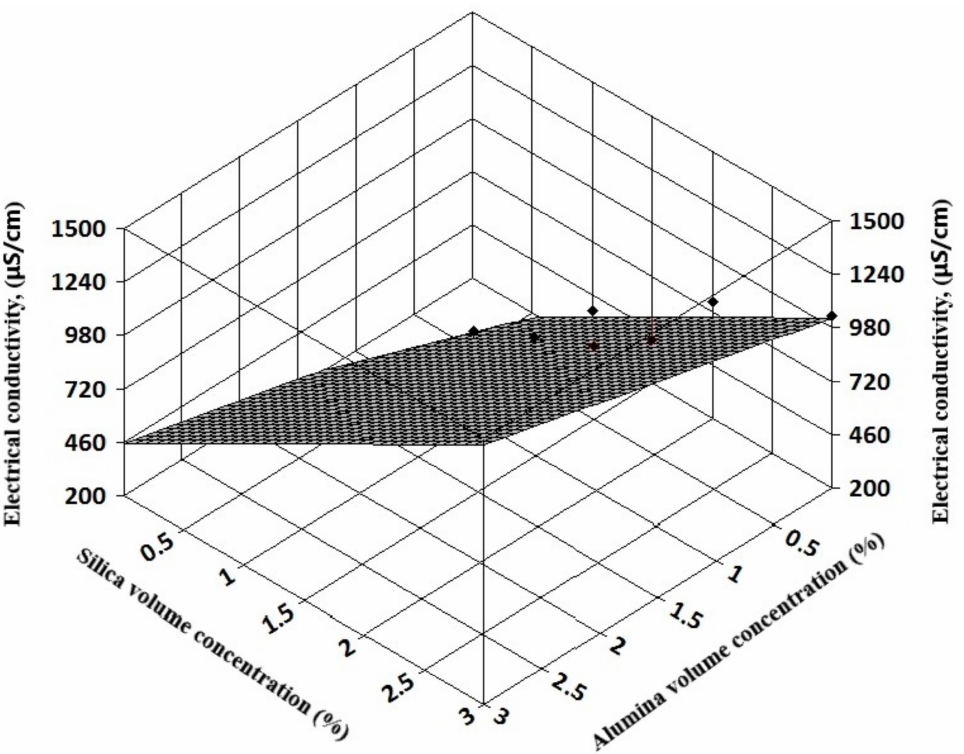
Figure 9. Three-dimensional analysis on alumina + silica hybrid nanofluids.